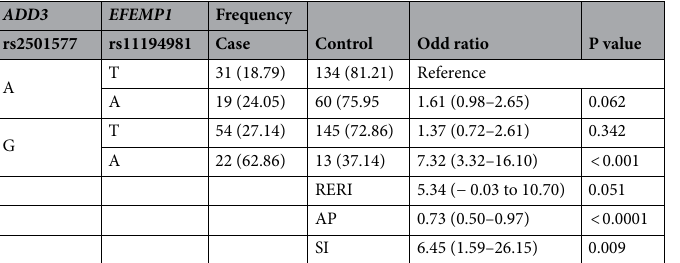
Table 3. Analysis of the biological interactions between allelotypes in the biliary atresia cases and